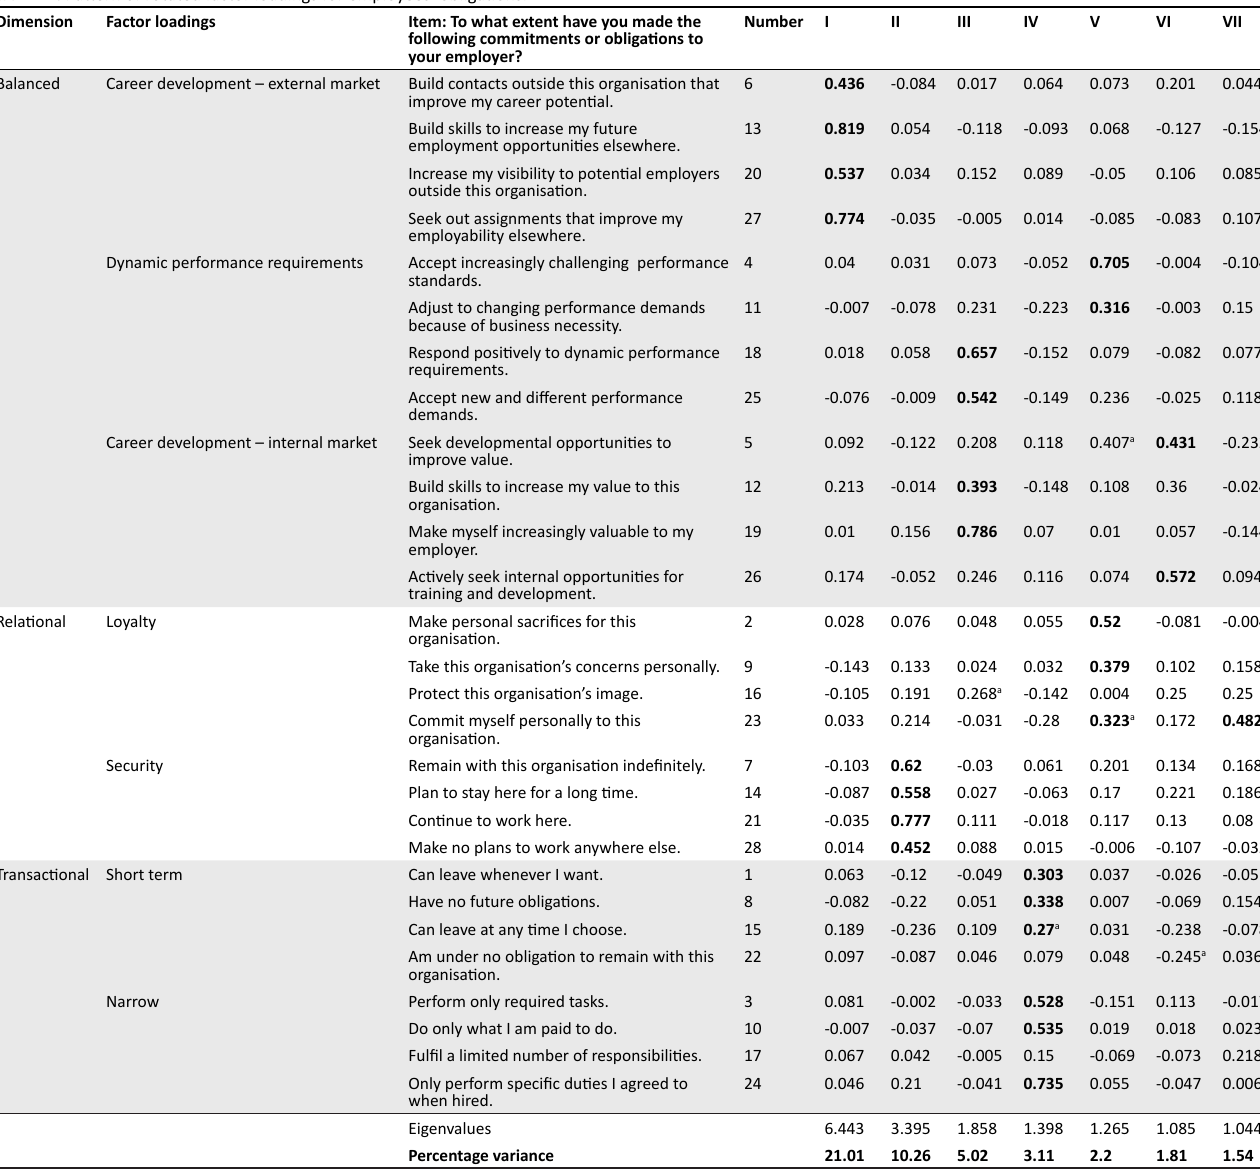
TABLE 2: Pattern of rotated factor loadings for employees’